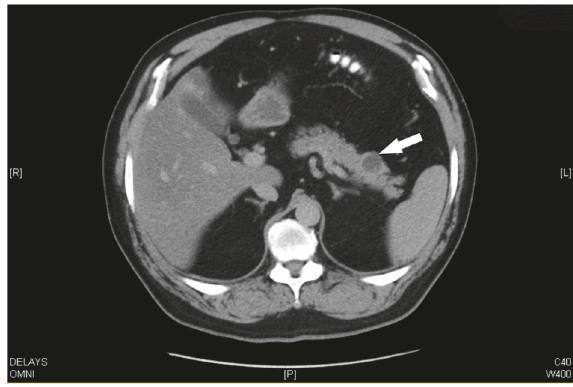
Figure 2: CT abdomen pelvis performed after EUS-FNA aspiration showing persistence of the cyst (arrow).